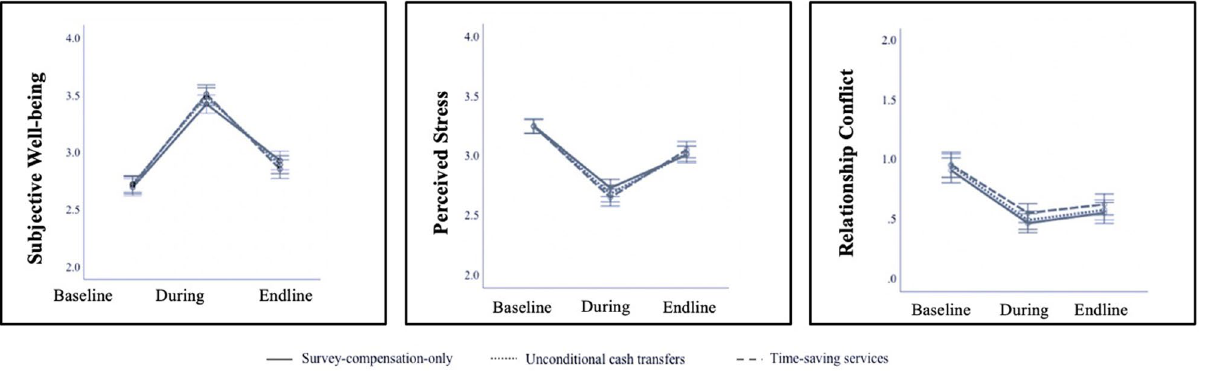
Figure 1. Effect of condition and time point on subjective well-being, perceived stress, and relationship conflict. This figure reports estimate marginal means and 95% confidence intervals by each condition and time point: at baseline (Week 1), during the intervention (weighted average of Weeks 3–5), and at endline (Week 6). As indicated by the confidence intervals that do not overlap, all outcome measures differed significantly from the baseline to endline measurements, suggesting that the positive impact of the condition assignments persisted even after the intervention ended. Outcome measures during the intervention were calculated as a weighted average of participants’ responses in Weeks 3, 4, and 5. For subjective well-being, the measure during the intervention was a weighted average of positive affect and negative affect in Weeks 3–5. The Satisfaction with Life scale was not included because it required a visual aid and was not administered in the phone survey during intervention